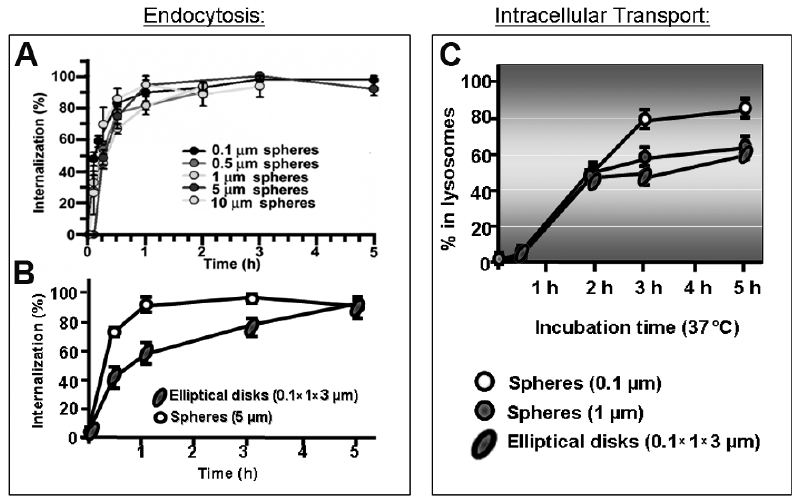
Figure 5. Role of carrier size and shape in the cellular uptake and trafficking via intercellular adhesion molecule 1 (ICAM-1). ( A ) Kinetics of endocytosis of spherical, ICAM-1-targeted polymer particles of various sizes by endothelial cells in culture. ( B ) Kinetics of uptake of micrometer-range size, ICAM-1-targeted polymer particles of spherical vs. elongated-disc shape. ( C ) Kinetics of lysosomal trafficking of said spherical vs. elongated polymer particles, also comparing nano- vs. micrometer-size range. Data are mean ± SEM. Adapted and reproduced with permission from Figures 4B and 6B in [184]. Copyright 2008 The American Society of Gene Therapy.